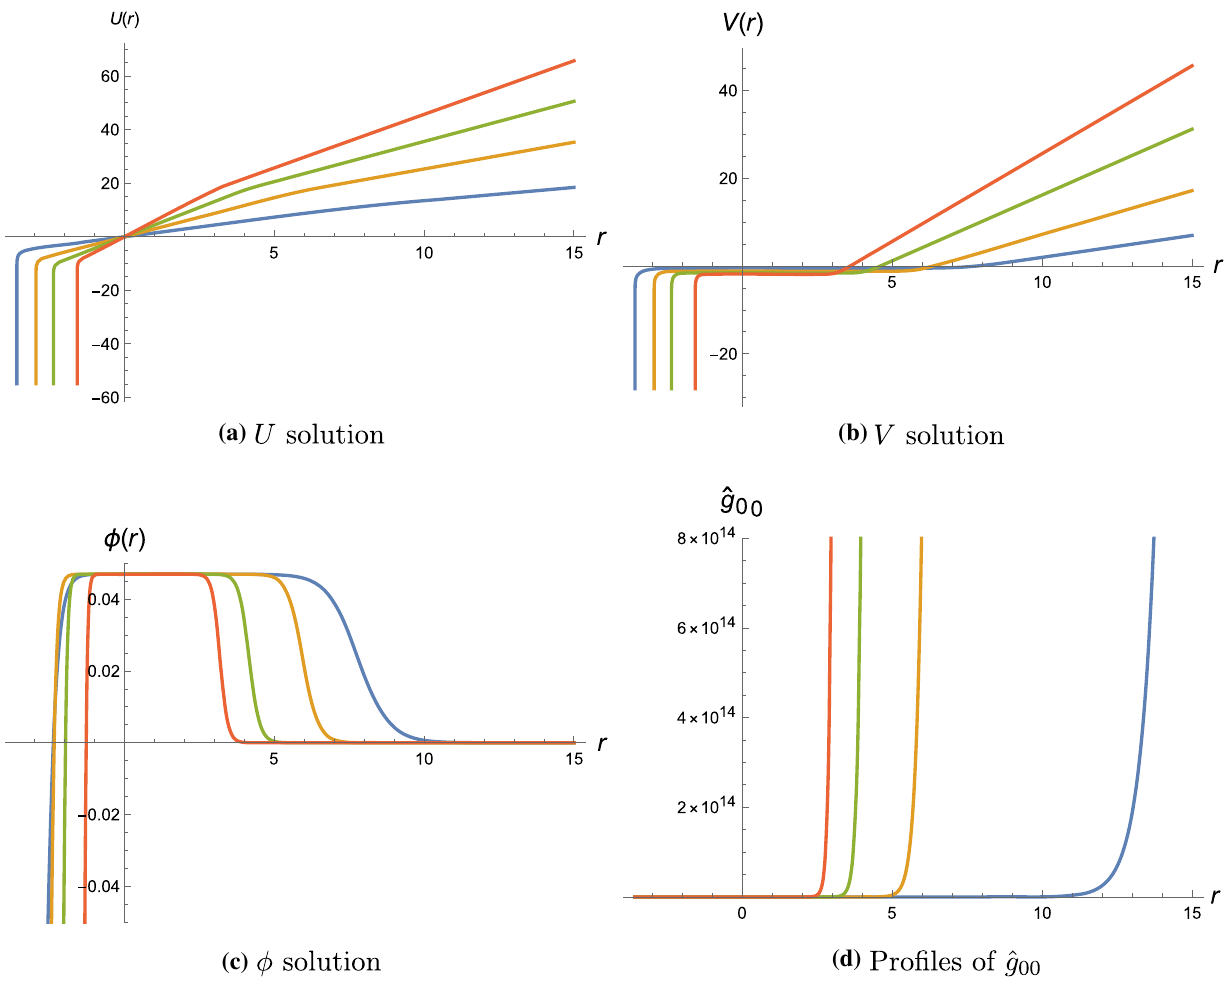
Fig. 11 RG flows from the N = 4 AdS 7 critical point to the AdS 4 × H 3 fixed point and curved domain walls for SO ( 3 ) + twists. The blue, orange, green and red curves refer to g = 8 , 16 , 24 , 32,